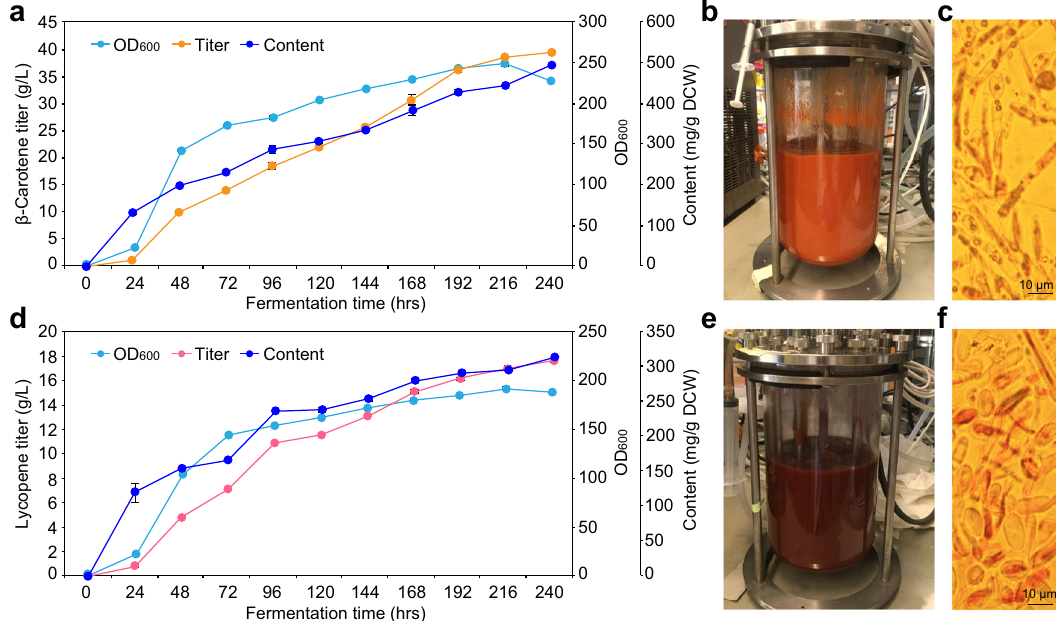
Fig. 6 Bioreactor fermentation of β -carotene and lycopene engineered Strains. a , d Fermentation pro fi les of the β -carotene-producing strain YLMA15 ( a ) and lycopene-producing strain YLMA34 ( d ) in a 3-L bioreactor. b , e β -carotene cultures displayed a deep red-orange color after 240 h cultivation ( b ), while lycopene cultures displayed a deep red color ( e ). c , f Microscopic images of cells producing β -carotene ( c ) and lycopene ( f ). β -carotene and lycopene are shown to accumulate intracellularly and dispersed throughout the cytoplasm in the most cells. For a and d , The average and s.d. of three biologically independent experiments are shown. For c and f , Three independent experiments were repeated with similar results. Source data are provided as a Source Data fi